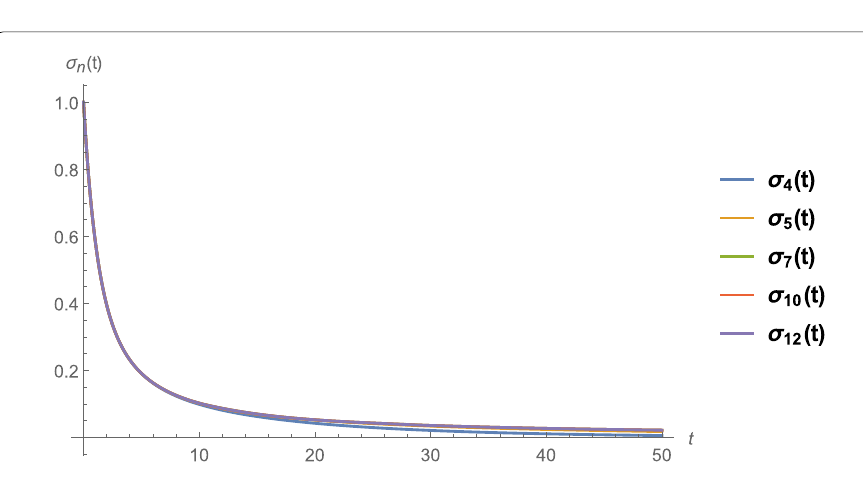
Figure 2 Convergence of current approximate solutions σ n ( t ), n = 4,5,7,10,12, at λ = 1, ξ = 2.5, and α =